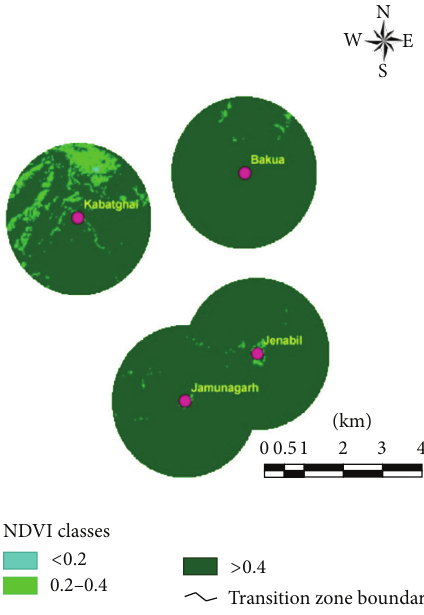
Figure 7: Vegetation density map in terms of NDVI classes of 5km bufferareasurroundingBakua,Jenasbil,Jamunagarh,andKabatghai for